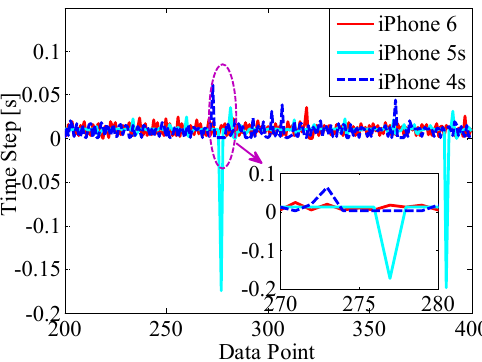
Figure 9. The time step between acceleration measurements as obtained by Orion-CC and the three different iPhone models show the relative stability of each system.